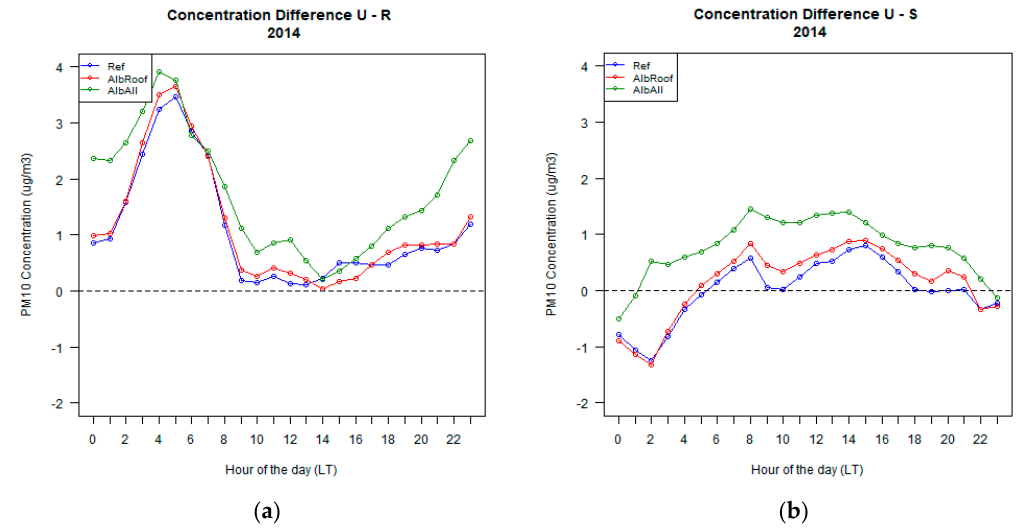
Figure 7. Same as Figure 3, but for PM10 concentration: ( a ) Average PM10 concentration difference computed over the mixed forest land use (Rural) category in Figure 1; ( b ) Average PM10 concentration difference computed over the croplands land use (Suburban) category in Figure 1.